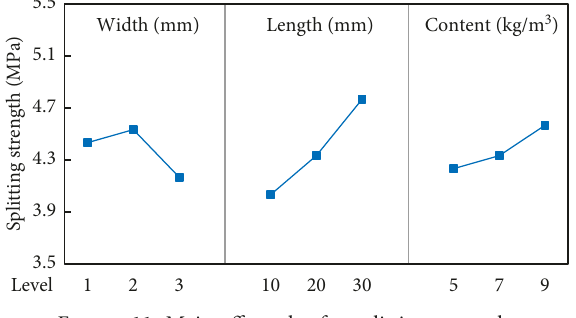
Figure 11: Main effect plot for splitting strength. Table 6: Analysis of variance results of wet-mix shotcrete (degree of freedom: